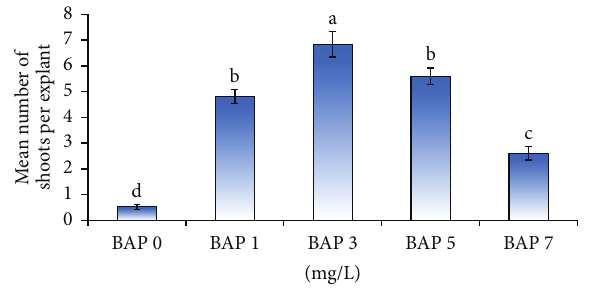
Figure 1: Effect of different concentrations of BAP (mg/L) on mean number of shoots per explant during shoot